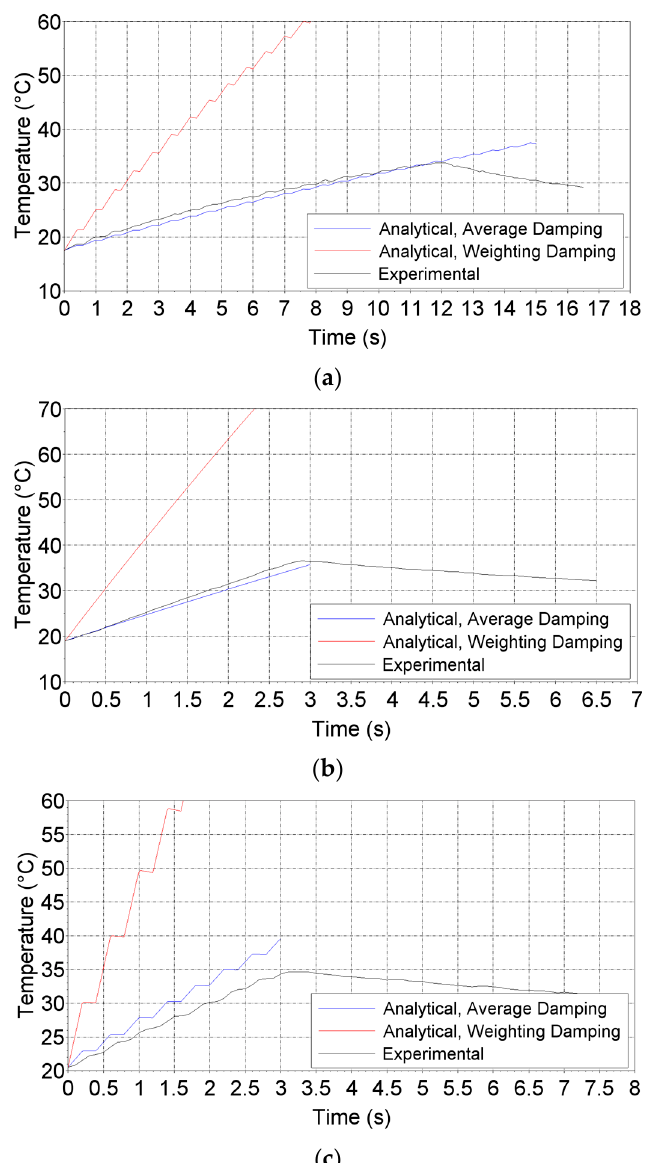
Figure 24. Experimental and computational model temperature comparison, S690 steel, UHCF specimen: ( a ) Maximum stress = 150 MPa, t on = 0.4 s, t off = 0.2 s, 20 pulses; ( b ) Maximum stress = 220 MPa, continuous excitation; ( c ) Maximum stress = 300 MPa, t on = 0.2 s, t off = 0.2 s, 8 pulses.